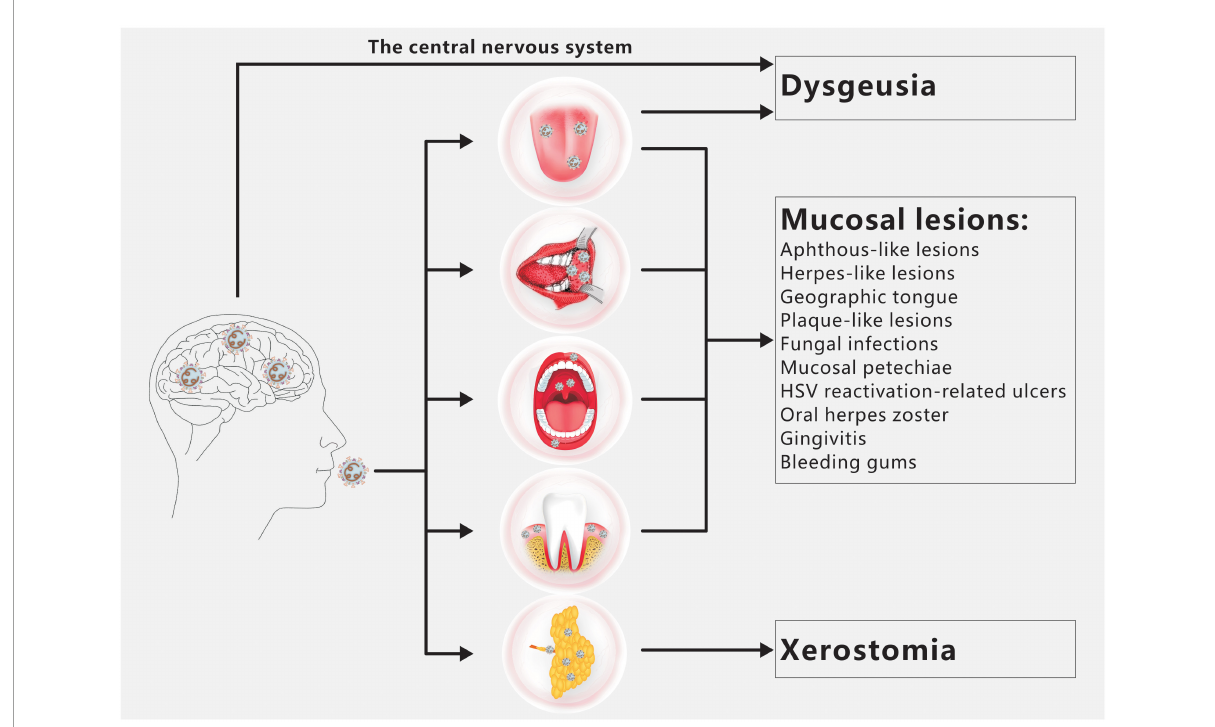
FIGURE1 Overview of COVID-19 oral manifestations. Dysgeusia, oral mucosal lesions and xerostomia are the main oral symptoms of COVID-19. SARS-CoV-2 infection of the CNS and/or taste buds is the main cause of dysgeusia. Oral mucosal lesions include aphthous-like lesions, herpes-like lesions, geographic tongue, plaque-like lesions, fungal infections, mucosal petechiae, HSV reactivation-related ulcers, oral herpes zoster, gingivitis and bleeding gums. The primary cause of xerostomia is SARS CoV-2 infection of salivary gland acinar cells and ductal